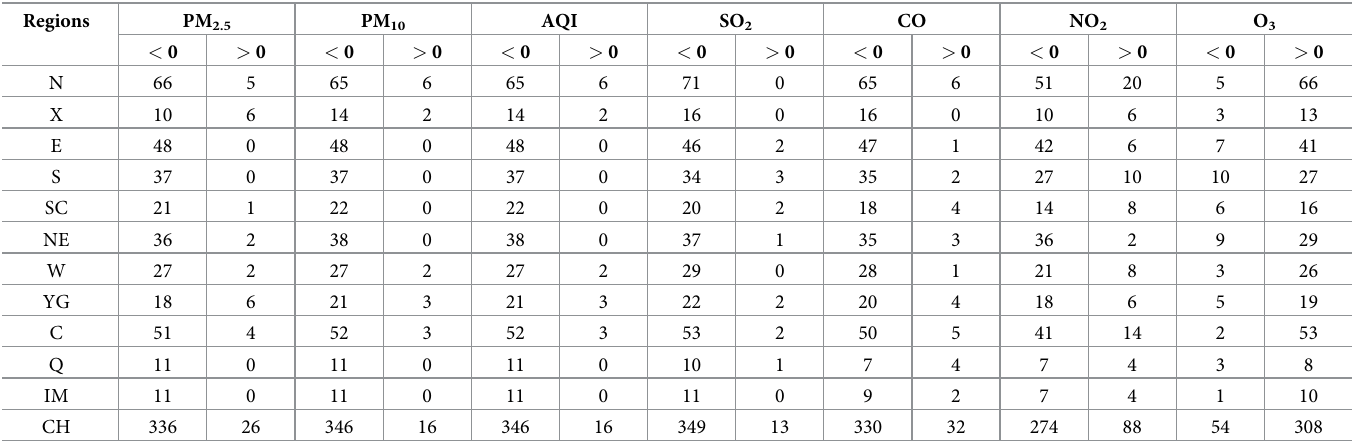
Table 5. Quantity of cities showing ‘ < 0’ and ‘ > 0’ of annual average relative change from 2015 to 2019, regions are indicated by the first capital letter. Regions PM 2.5